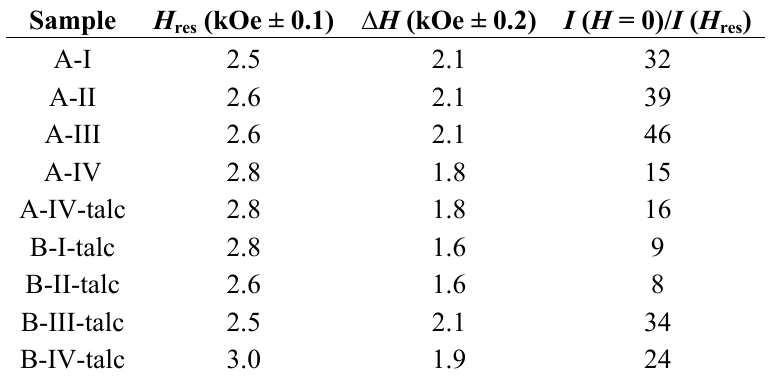
Table 3. Microwave properties of A and B series samples with and without dilution (1:3 parts of talc); f = 9.5 GHz.